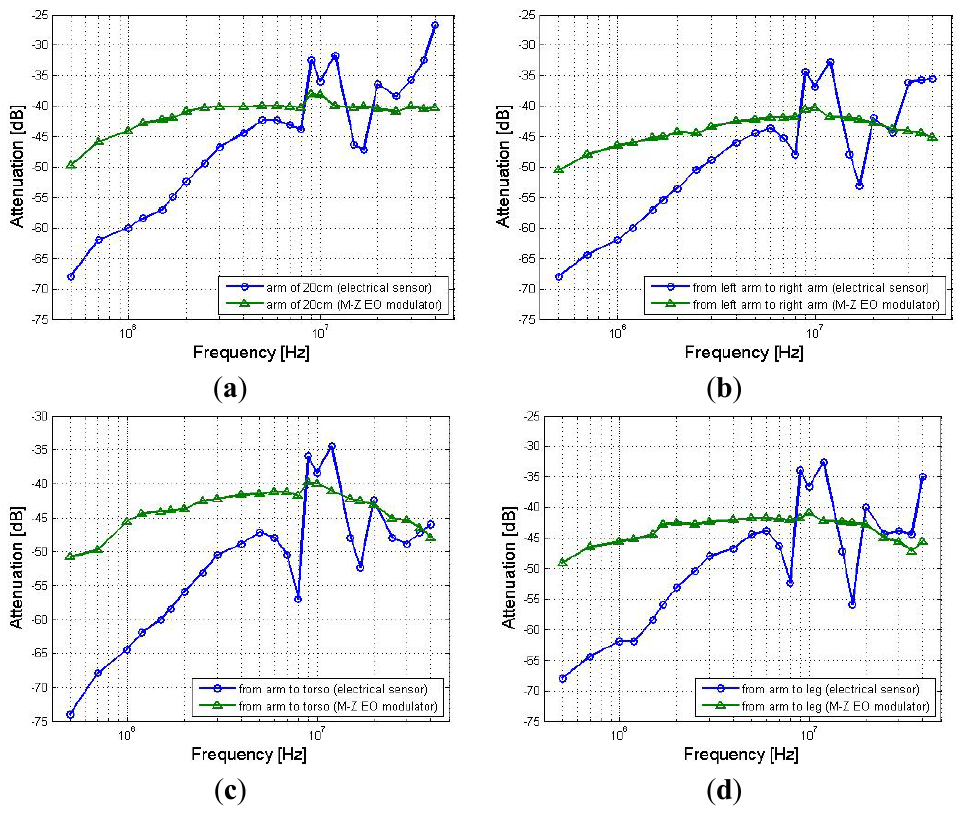
Figure 6. The experiment results of the frequency response corresponding to the